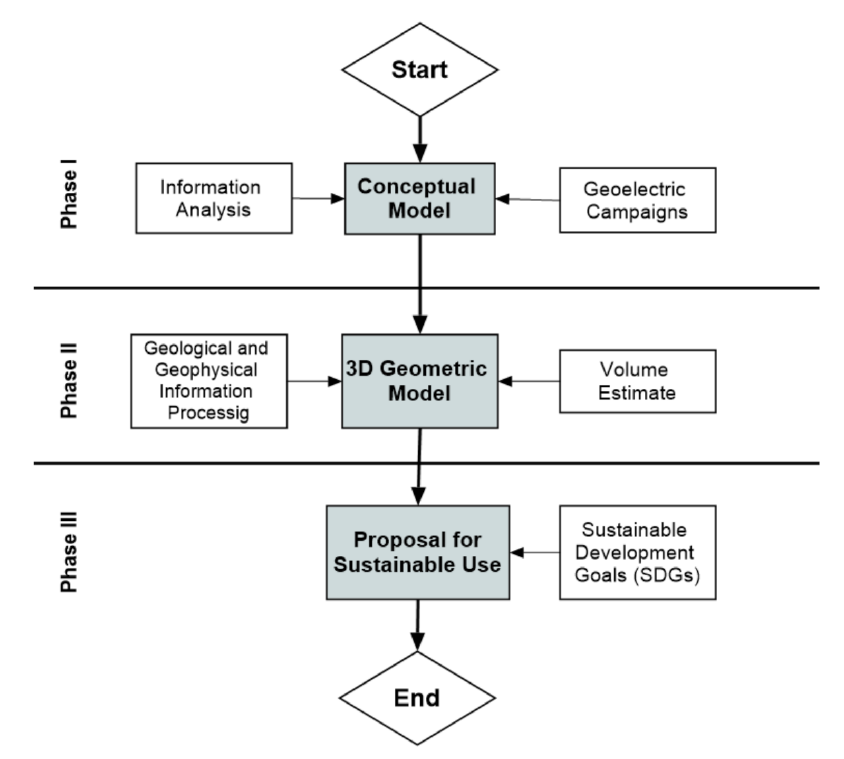
Figure 2. Scheme of the methodology of this